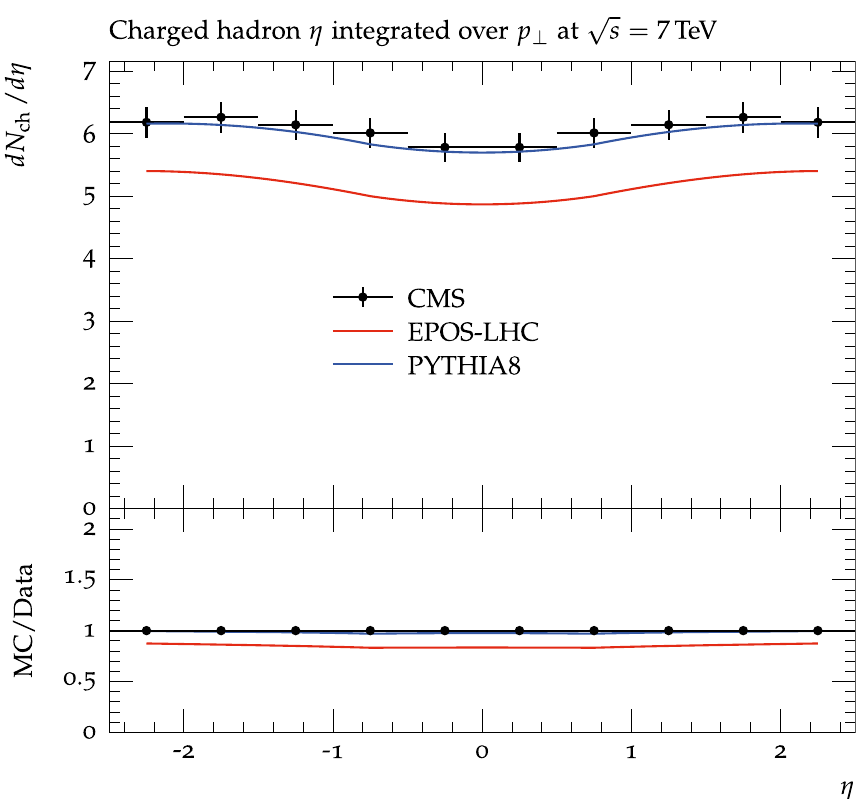
η 2.5 measured by the CMS experiment is ≤ ≤